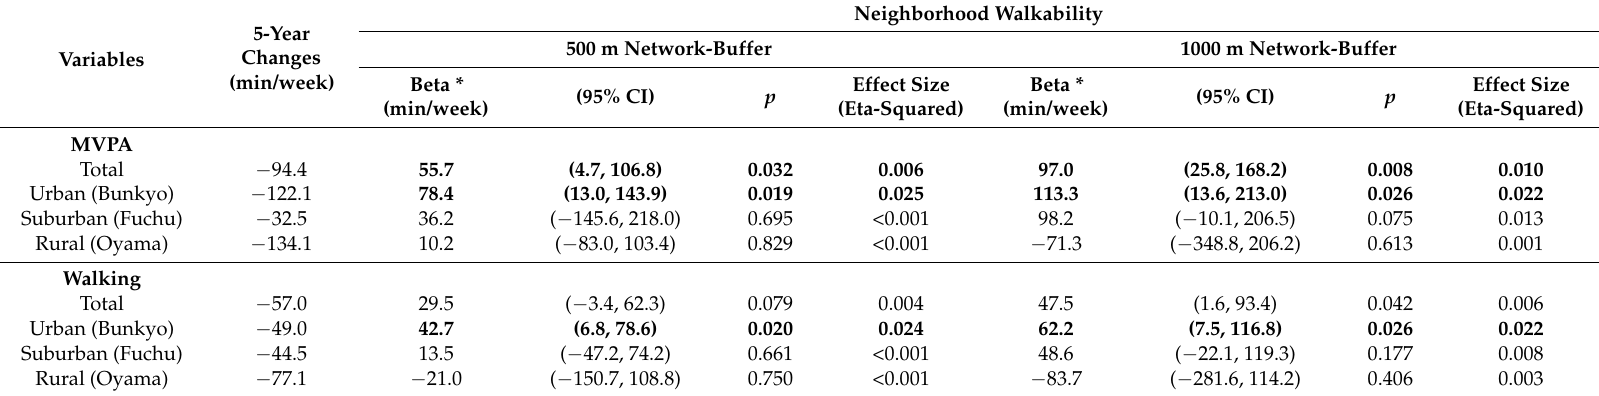
Table 4. Association between neighborhood walkability and change in total MVPA and walking during the 5-year period by area of residence: Multivariate regression